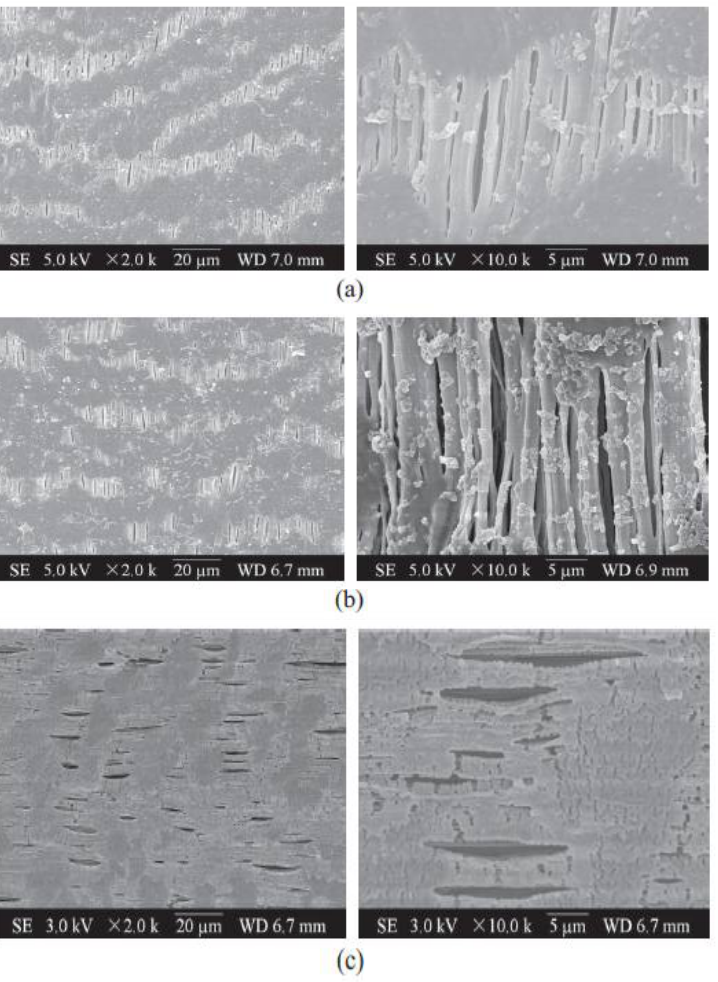
Figure 28. Morphology images of PTFE membrane after a HA solution concentration experiment under ultrasonic irradiation: ( a ) 2 Mm CaCl 2 ; ( b ) 10 Mm CaCl 2 ; ( c ) 20 Mm CaCl 2 [139].